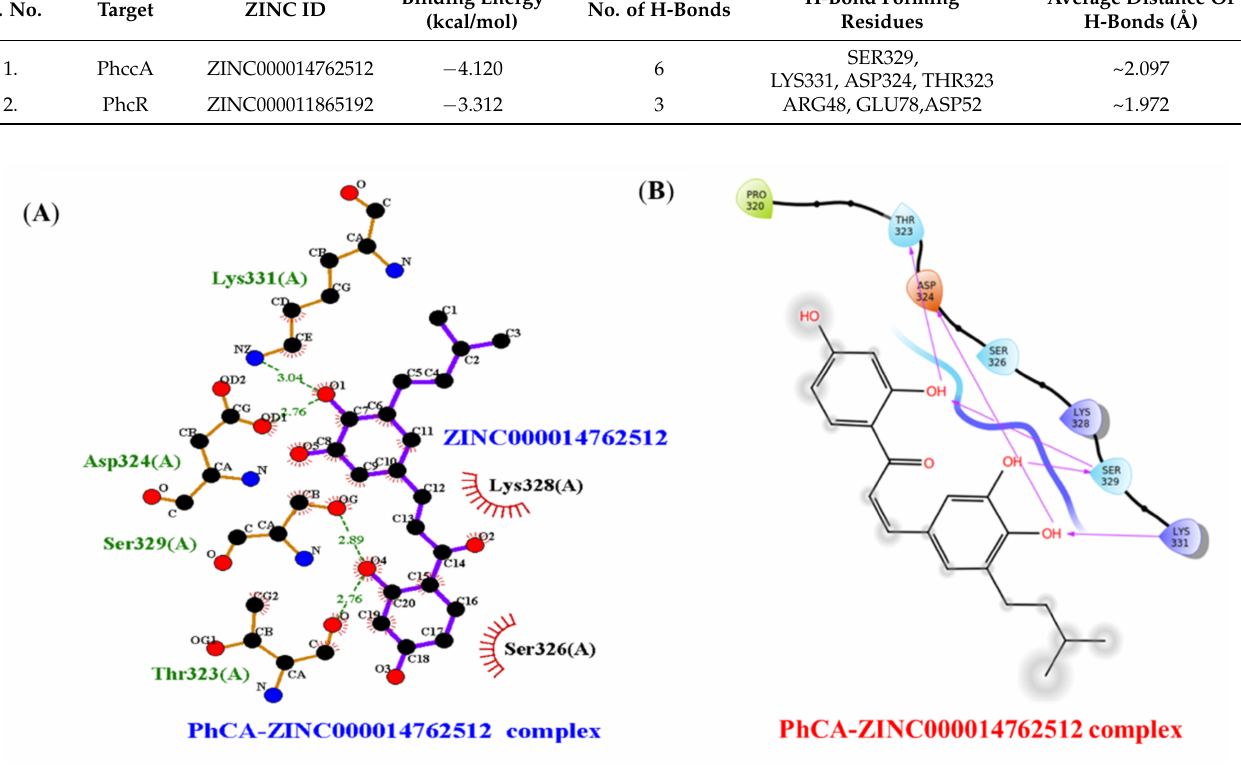
Figure 4. Intermolecular H-bonding, electrostatic, and hydrophobic interactions formed between PhccA–ZINC000014762512 complexes. The image ( A ) is drawn by the LigPlot+ tool and ( B ) ligand interaction module of Schrödinger.